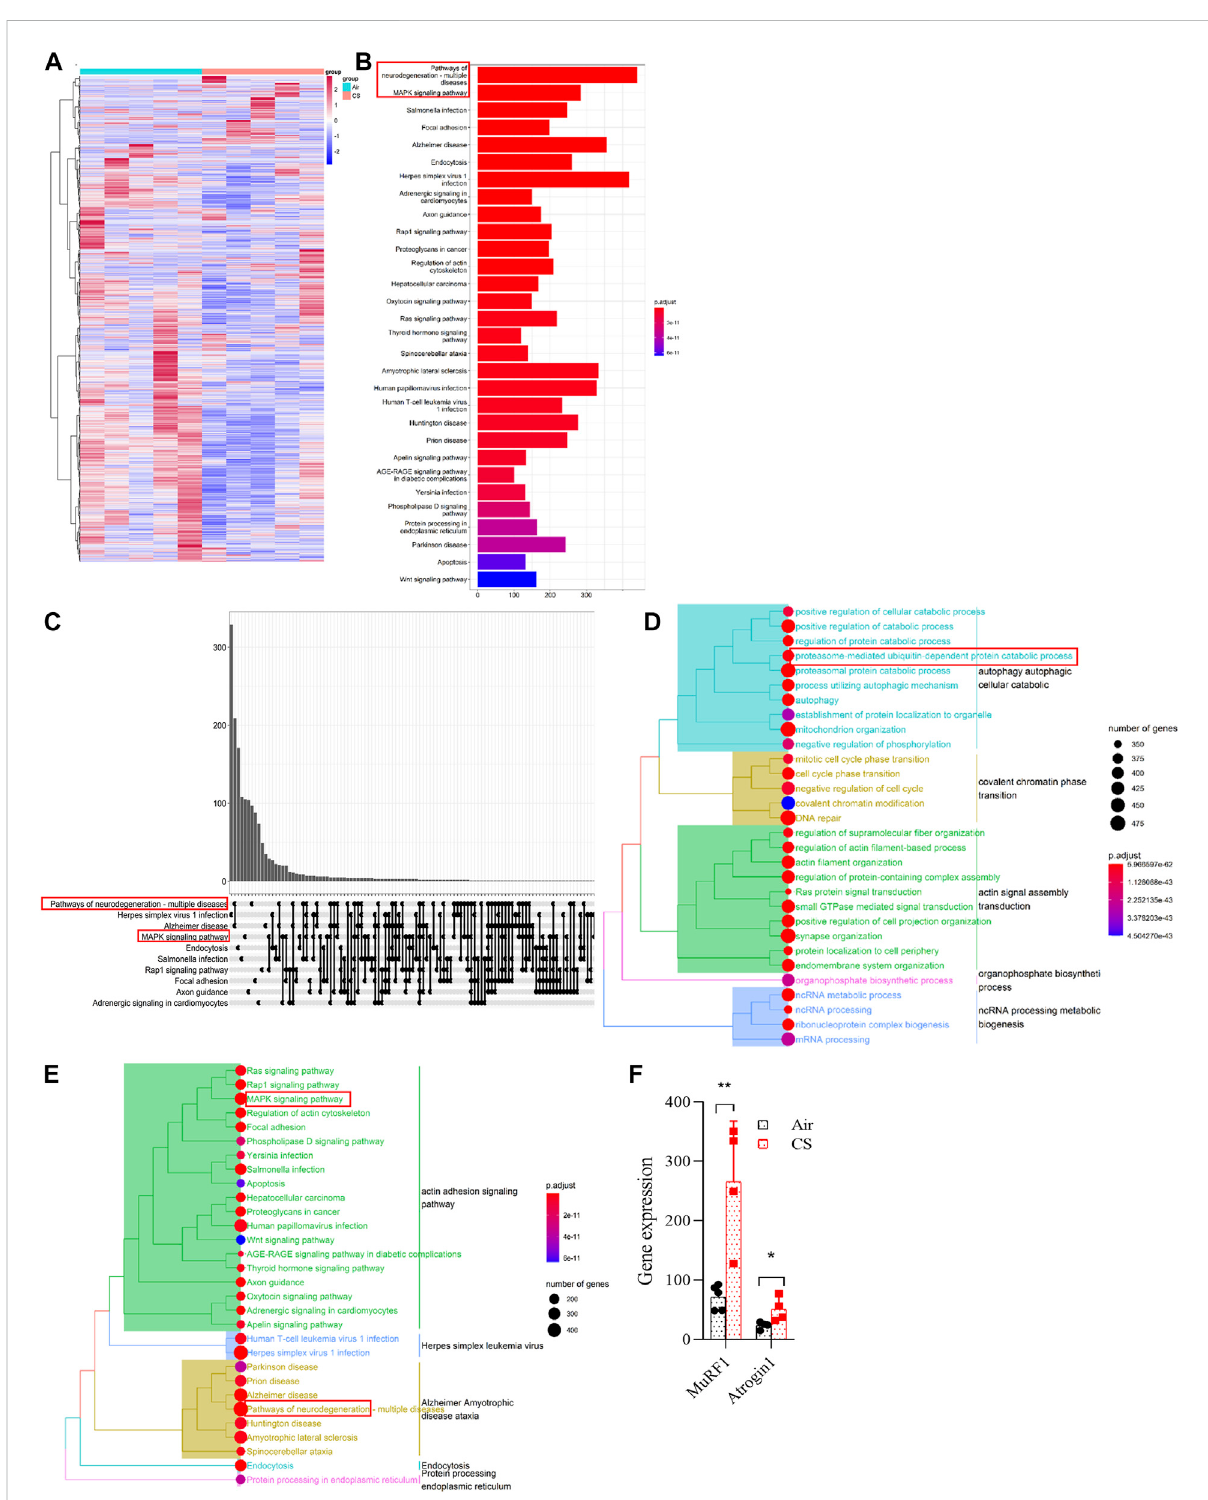
FIGURE 2 Neurodegeneration, MAPK, and ubiquitin-proteasome signaling pathways were upregulated in skeletal muscles of chronic obstructive pulmonary disease mice. (A) heatmap showing the enrichment of genes in gastrocnemius muscle by RNA sequencing. (B,C) histogram and upset plot showing the enrichment results of KEGG. (D) GO treeplot showing the different signaling pathways using average expression of differential genes in the gastrocnemius muscle. (E) KEGG treeplot showing the different signaling pathways using average expression of differential genes in the gastrocnemius muscle. (F) gene expression of MuRF1 and Atrogin1 in RNA-seq. n = 5, * p < 0.05, ** p <